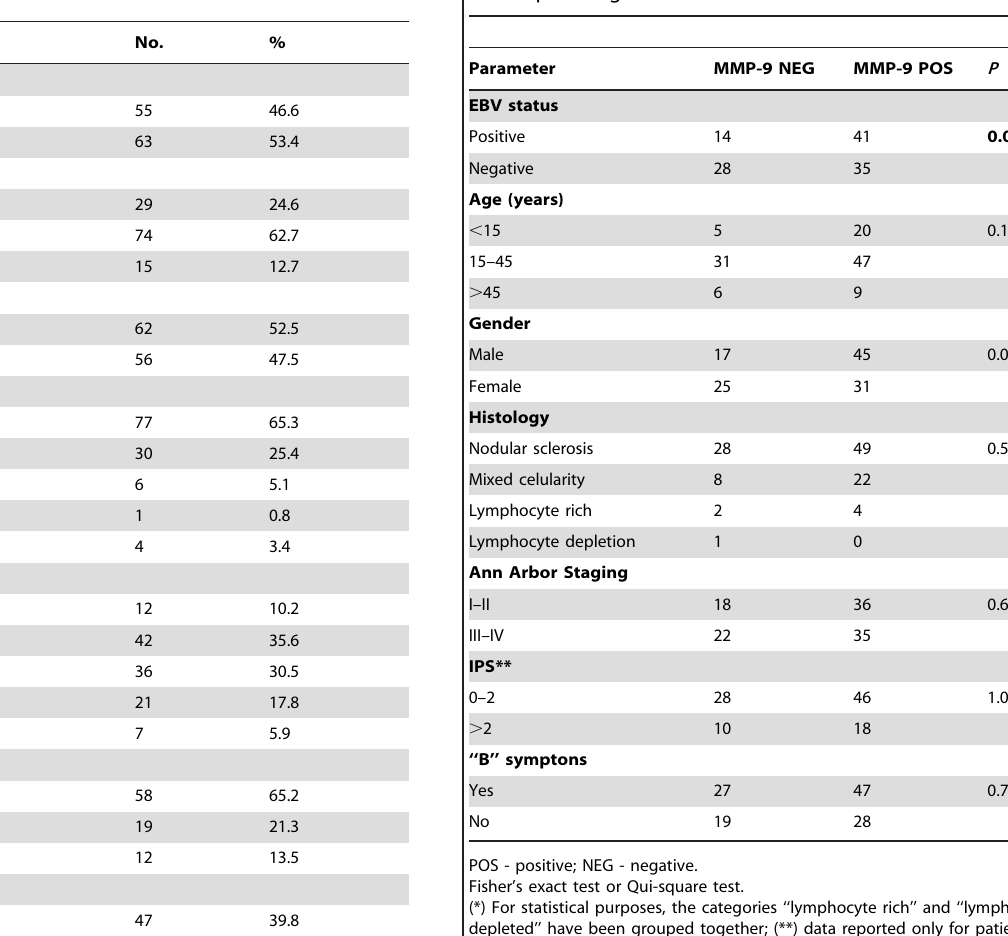
Table 1. Clinico-pathological features of 118* cHL patients. Table 2. Correlation of MMP9 expression with EBV status and clinico-pathological features.